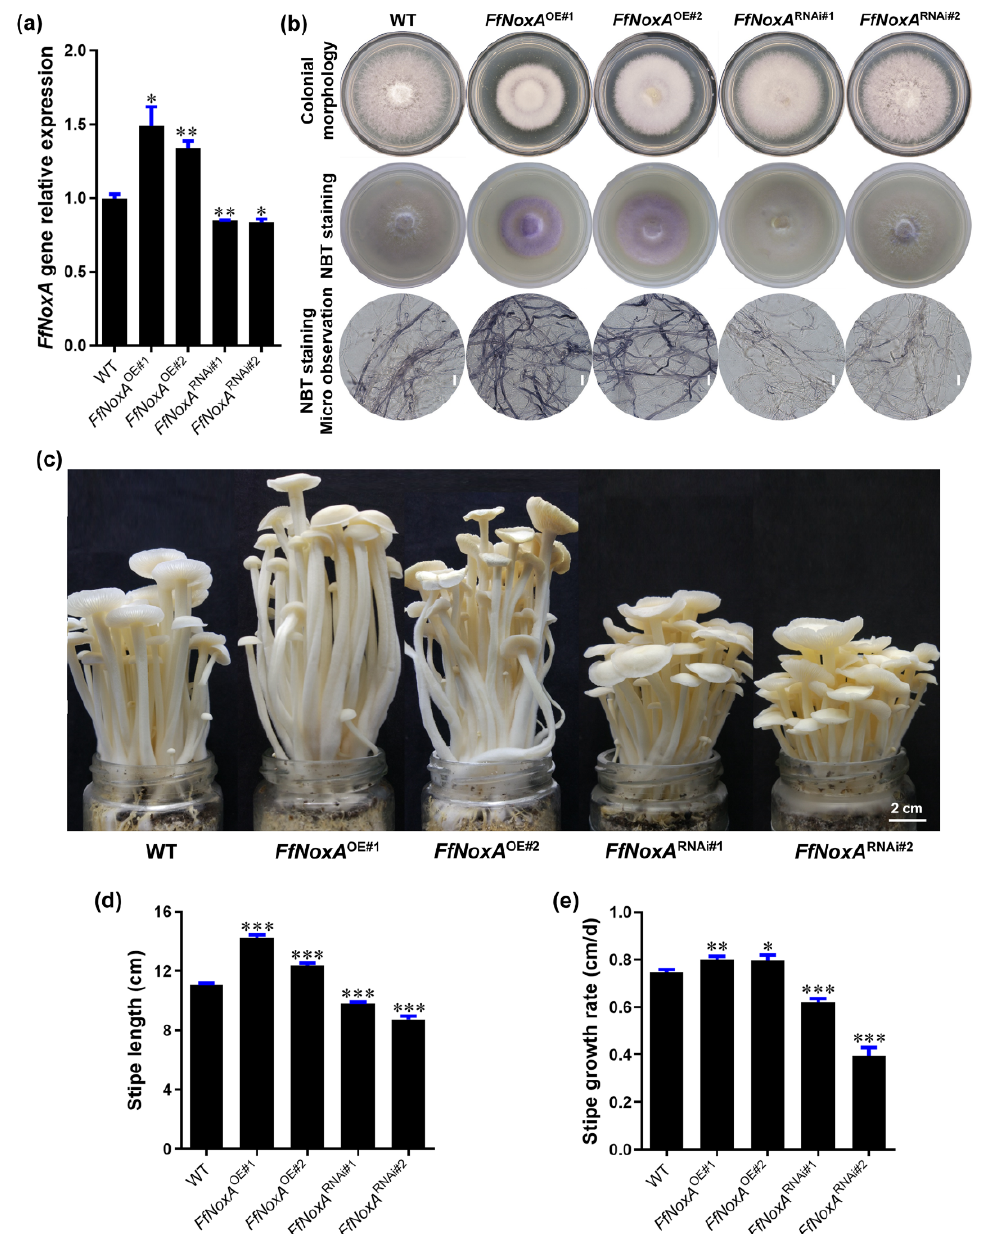
Figure 5. Gene expression, ROS detection, and stipe elongation phenotype in the wild type (WT) and FfNoxA overexpression and RNAi lines. ( a ) The relative expression of FfNoxA in the WT, overexpression lines, and RNAi lines. ( b ) Colony morphology and histochemical staining of cells with NBT for O 2 − detection (purple) in FfNoxA overexpression and RNAi lines (Bar = 20 µ m). ( c ) The phenotype of fruiting bodies at the maturation stage (Bar = 2 cm). ( d ) The total stipe length at the maturation stage ( n = 35). ( e ) Growth rate measurement of the 0–1.5 cm stipe region in FfNoxA overexpression and RNAi lines ( n = 25). The significance levels were calculated by paired t -test compared with the WT sample, * p < 0.05, ** p < 0.01, *** p < 0.001.